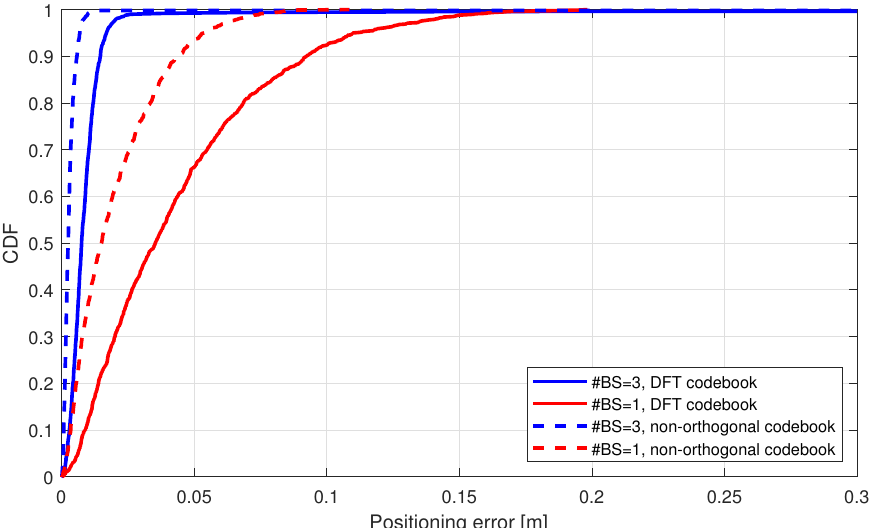
Figure 13. Urban scenarios (<50 m) mmWave NLS positioning with LoS link from one or three base stations.